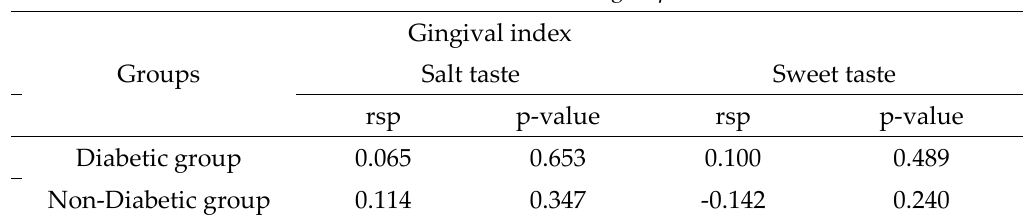
Table (7): The correlation coefficient between sweet and salt taste thresholds with gingival index among